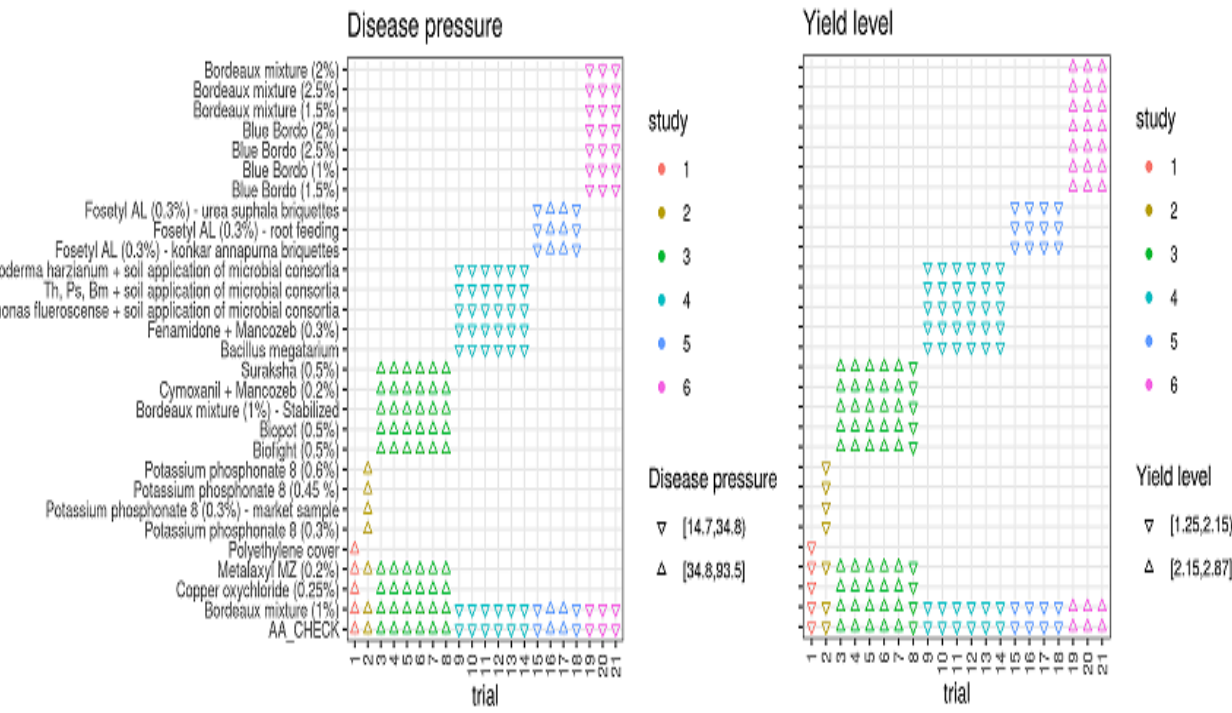
Figure 3. Categorization of trials based on trial mean values for disease pressures and yield levels among the treatments conducted with multi-environment profiles from 2012 to 2019. Th = Trichoderma harzianum ; Ps = Pseudomonas fluorescence ; Bm = Bacillus megatarium .